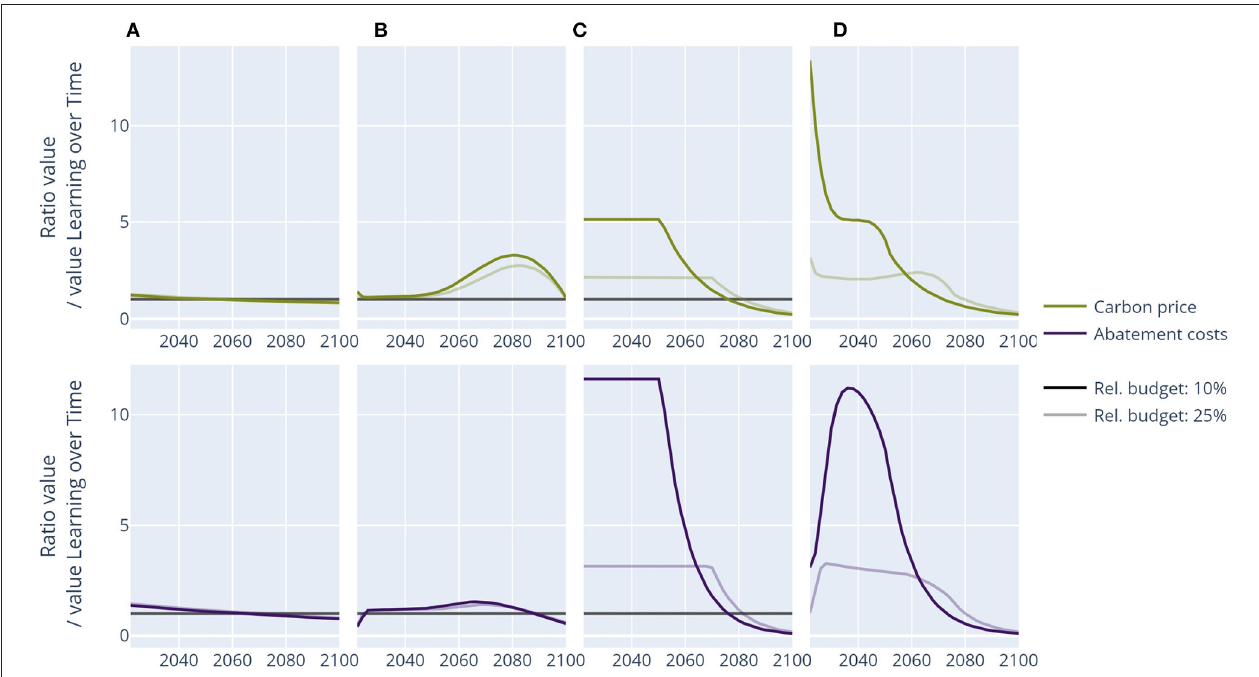
FIGURE 5 | Carbon price pathways and abatement costs relative to the learning over time pathway: 1.5 ◦ C budget (25% of cumulative baseline emissions) compared with 2 ◦ C budget (10% of cumulative baseline emissions). (A) Learning by doing, (B) socio-economic inertia , (C) minimum emission level, and (D)